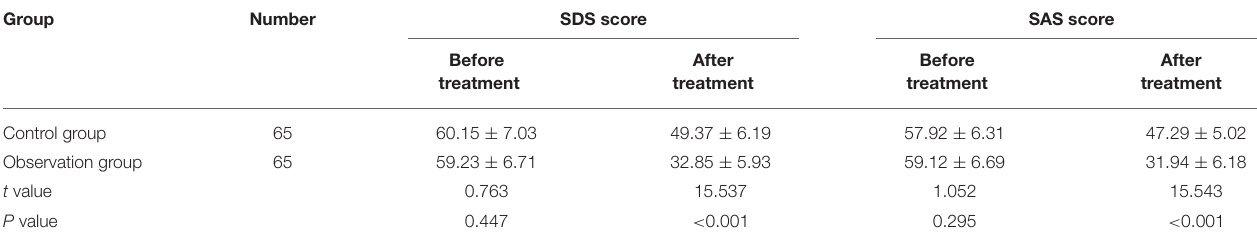
TABLE 3 | Comparison of the SDS and SAS scores between the two groups before and after treatment. Group Number SDS score SAS score